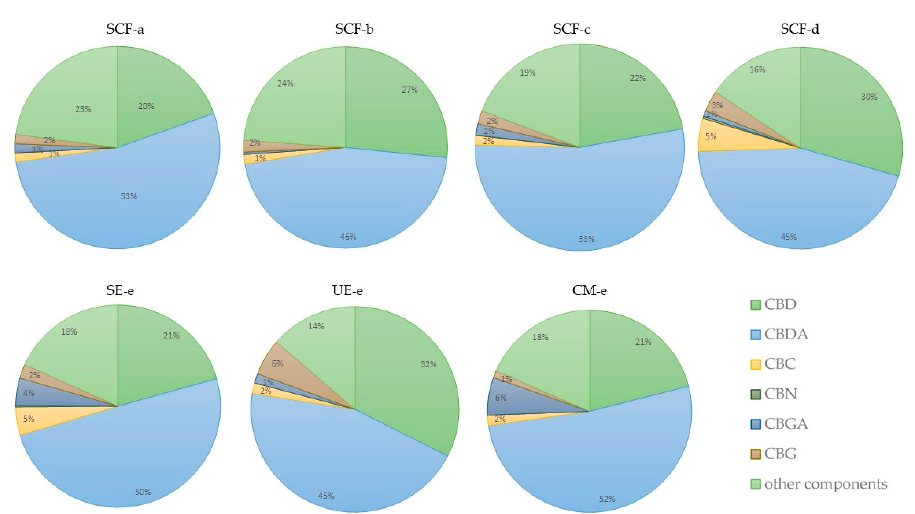
Figure 5. Cannabinoid component of Cannabis Sativa L. extract. Analyses were performed in duplicate and values expressed as cannabinoid percentage. The procedure for obtaining the percentage results is described in Section 3.2.5. Table 3. Minimum inhibitory concentration MIC [mg / mL] of six di ff erent ginger-industrial hemp extracts.